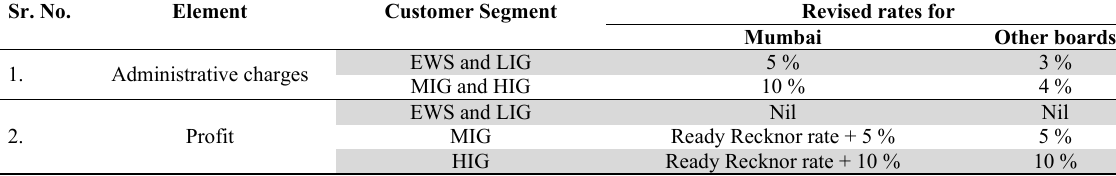
Revised rate for various income groups (Source: MHADA Circular) Sr. No. Element Customer Segment Revised rates for Mumbai Other boards EWS and LIG 5 % 3 % 1. Administrative charges MIG and HIG 10 % 4 % EWS and LIG Nil Nil Profit MIG 10